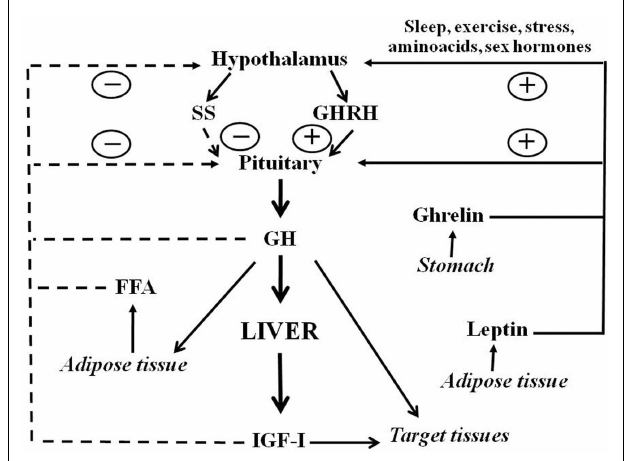
FIGURE 1 | Schematic representation of somatotropic axis . GHRH and SS, two hypothalamic hormones, control the synthesis and release of GH from the pituitary. GHRH is negatively (dashed lines) regulated by feedback from blood GH and IGF-I concentrations. FFA also inhibits whereas leptin and ghrelin stimulate GH release. Sex hormones and other factors also act centrally to stimulate GH release. Circulating GH acts directly on many organs to stimulate IGF-I production, with IGF-I production in the liver providing the main source of blood IGF-I. GH also has direct effects on many target tissues which can be independent of IGF-I